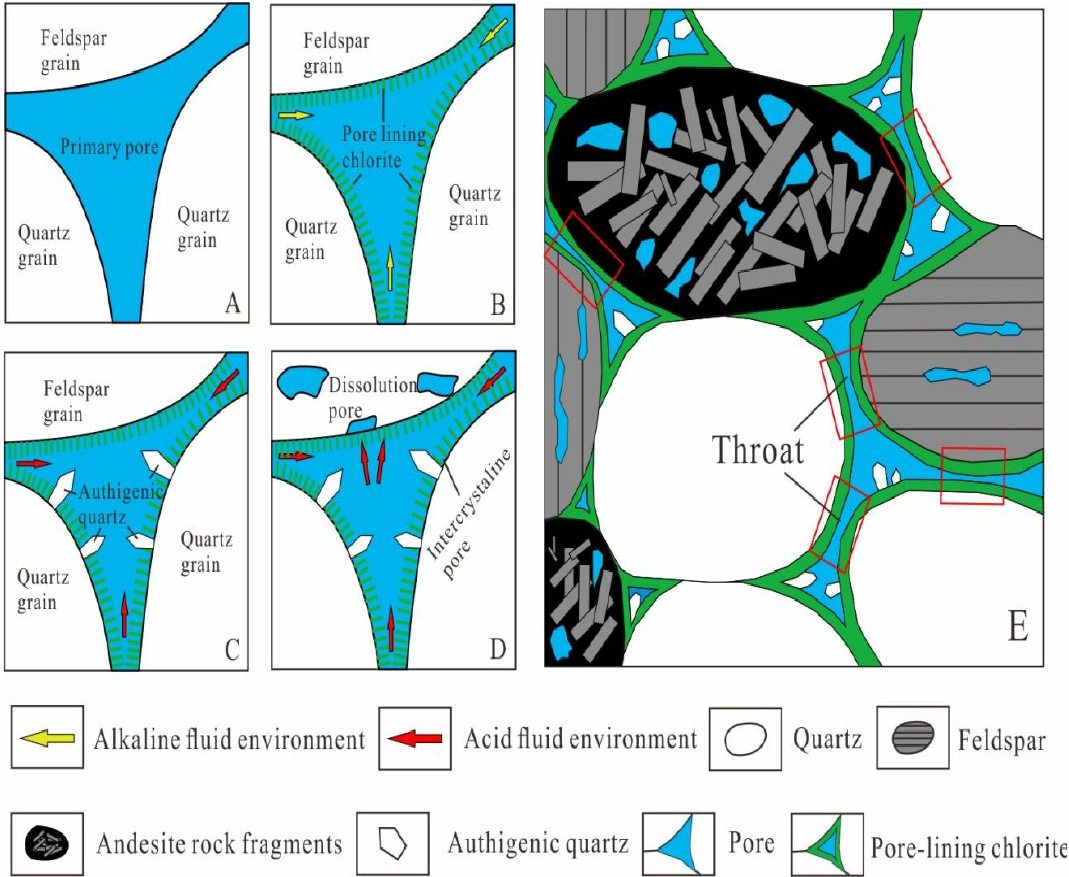
Figure 14. In fl uence of pore-lining chlorite on pore structure of tight clastic rock reservoir. ( A ) In the initial deposition stage, primary intergranular pores developed. ( B ) In the early diagenesis period, under weakly alkaline conditions, the pore-lining chlorite developed. ( C ) During the mid-diagenesis period, authigenic microcrystalline quar tz gradually formed under acidic conditions. ( D ) The acidic fl uid contacts the feldspar particles through the chlorite intercrystalline pores and then forms intra- granular dissolved pores. ( E ) When the pore-lining chlorite is developed, the pore structure appears as large pores and narrow throats.